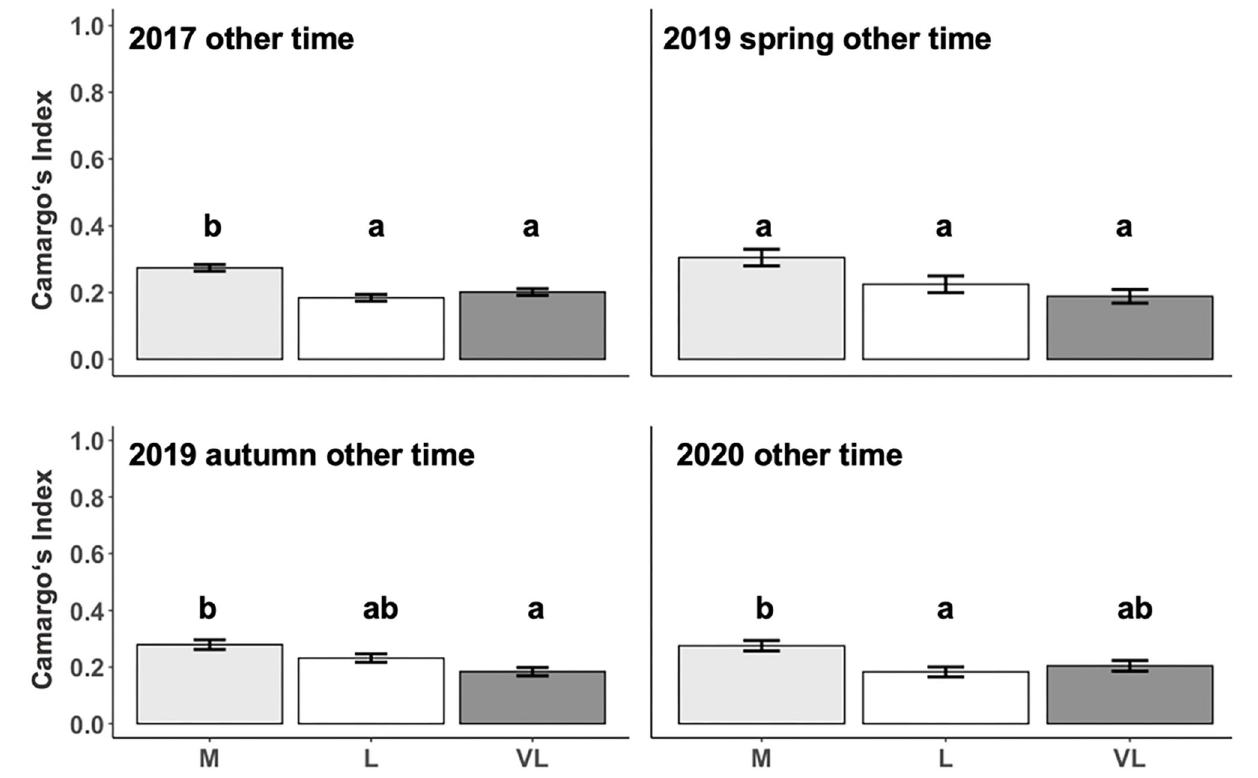
FIGURE 4 | Estimated means ( ± SE) of the Camargo Index during other time as influenced by the grazing period and grazing intensity. M, moderate; L, lenient; VL, very lenient stocking rate. Identical Lowercase letters indicate that means are not different at p < 0.05 within